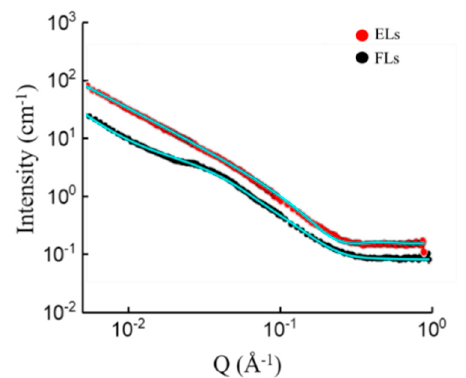
Figure 3. Scattering curves of DOPE/DOTAP/BODIPY-FL-DHPE (1/1/0.1 mol/mol) ( black circles ) liposomes and DOPC/DOTAP/BODIPY-FL-DHPE (1/1/0.1 mol/mol) ( red circles ) liposomes measured at 37 °C. Cyan lines indicate corresponding fits of a single measurement.